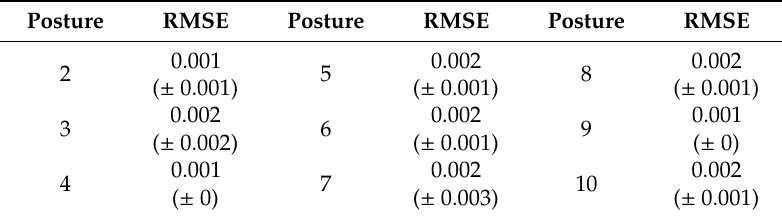
Figure 5. Registration of a bone in the template posture to that in a target posture: ( a ) Selection of three points at a similar position, each from the template bone surface and the target bone surface; ( b ) Initial registration by aligning the selected points; ( c ) Fine registration. Table 1. Mean ( ± S.D.) registration accuracy of the hand skeletons ( n = 15) in the template posture (posture 1) to those in the other postures (postures 2 to 10) measured by root mean square error (RMSE) of Hausdorff distance (unit: mm).